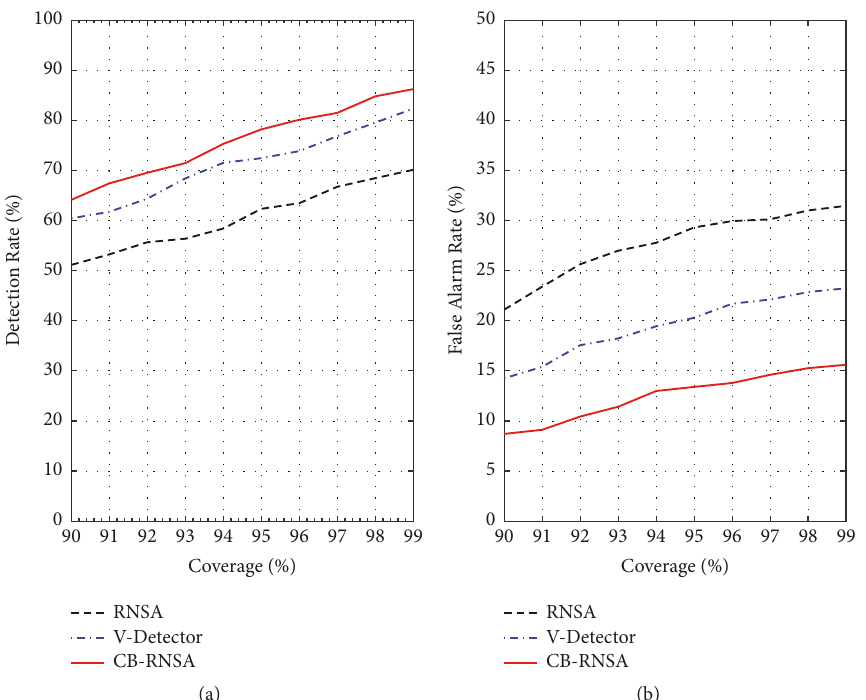
Figure 18: Comparisons of detection rates and false alarm rates of RNSA, V-Detector, and CB-RNSA (BCW1).